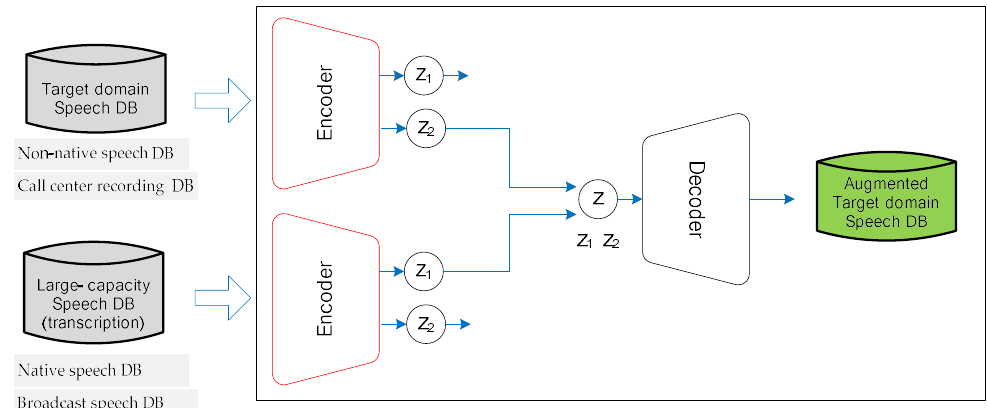
Figure 4. Graphic illustration of the data augmentation step of the proposed method.